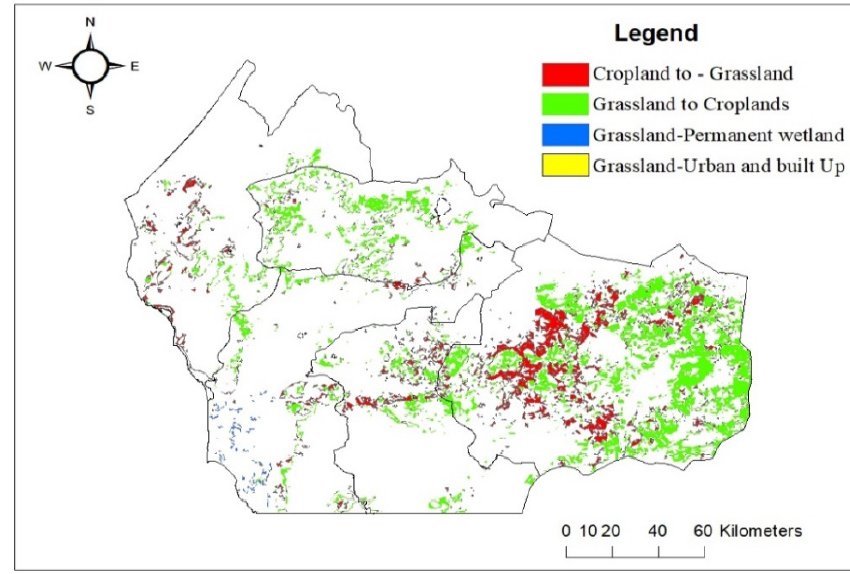
Figure 4. Land use transition throughout the study period